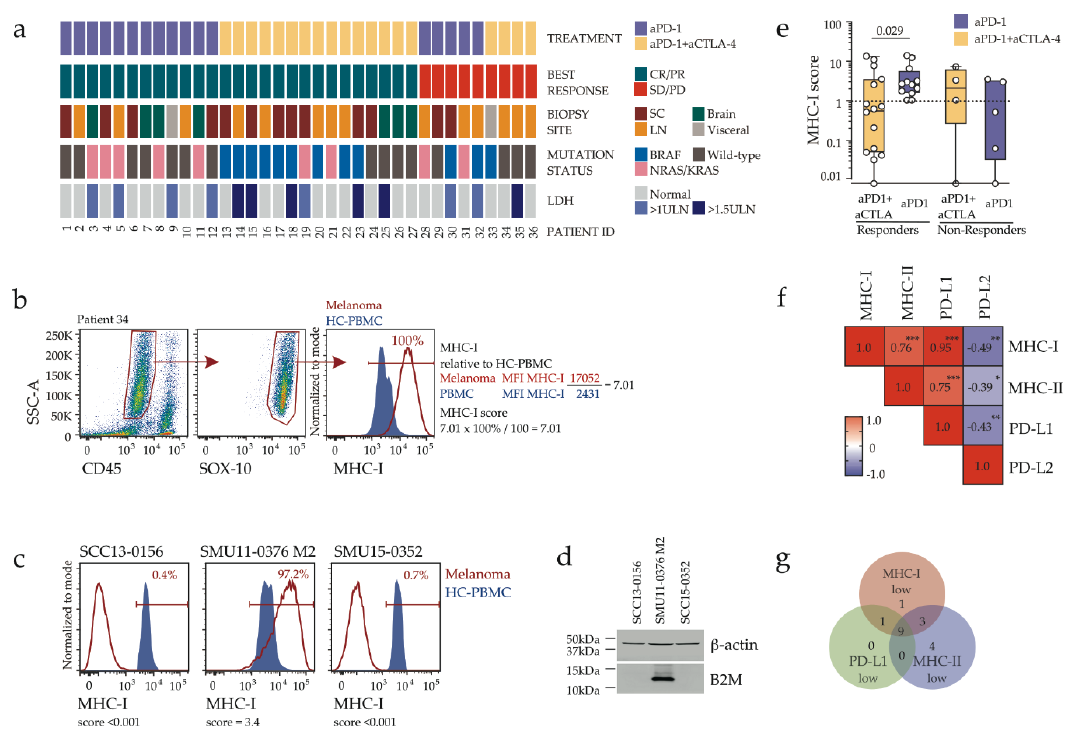
Figure 1. Tumor expression of MHC-I is associated with response to PD-1 inhibitor monotherapy, but not combination immunotherapy. ( a ) Details of the 36 melanoma pre-treatment biopsies analyzed in this study, including 17 from patients subsequently treated with anti-PD-1 (aPD-1) and 19 from patients treated with combination (aPD-1+aCTLA-4) immunotherapy. Patient responses as defined by RECIST criteria, biopsy site, driver mutations and LDH status are shown. CR, complete response; PR, partial response; SD, stable disease; PD, progressive disease; LN, lymph node; SC, subcutaneous, Visceral, non-brain visceral, ULN, upper limit of normal. ( b ) Representative flow cytometry analysis showing melanoma cell gating and calculation of the MHC-I expression score. Histograms show expression of MHC-I on melanoma cells (red) and healthy control peripheral blood mononuclear cells (HC-PBMC; blue shaded histogram). ( c ) Lack of tumor MHC-I expression in two B2M-deficient melanoma biopsies, with MHC-I score indicated. An MHC-I positive melanoma tumour was included for comparison. ( d ) B2M protein expression in short-term melanoma lines derived from the melanoma biopsies shown in (c); kDa, kilodalton. ( e ) Melanoma MHC-I expression score, stratified by therapy and patient’s response. Boxes show the interquartile range and the median, with Mann-Whitney’s p value indicated. Dotted line indicates positivity threshold (=1.0). Values below 0.01 are shown as zero. ( f ) Correlation matrix of melanoma cell expression of MHC-I, MHC-II, PD-L1 and PD-L2. Spearman’s rank correlation values are shown within the matrix, with asterisks indicating the p values (* p < 0.05; ** p < 0.01; *** p < 0.001). ( g ) Venn diagram showing the distribution of tumors with low / negative MHC-I (score < 1.0, n = 14), low / negative MHC-II (score < 0.1, n = 16) and low / negative PD-L1 expression (score < 1.0, n = 10).